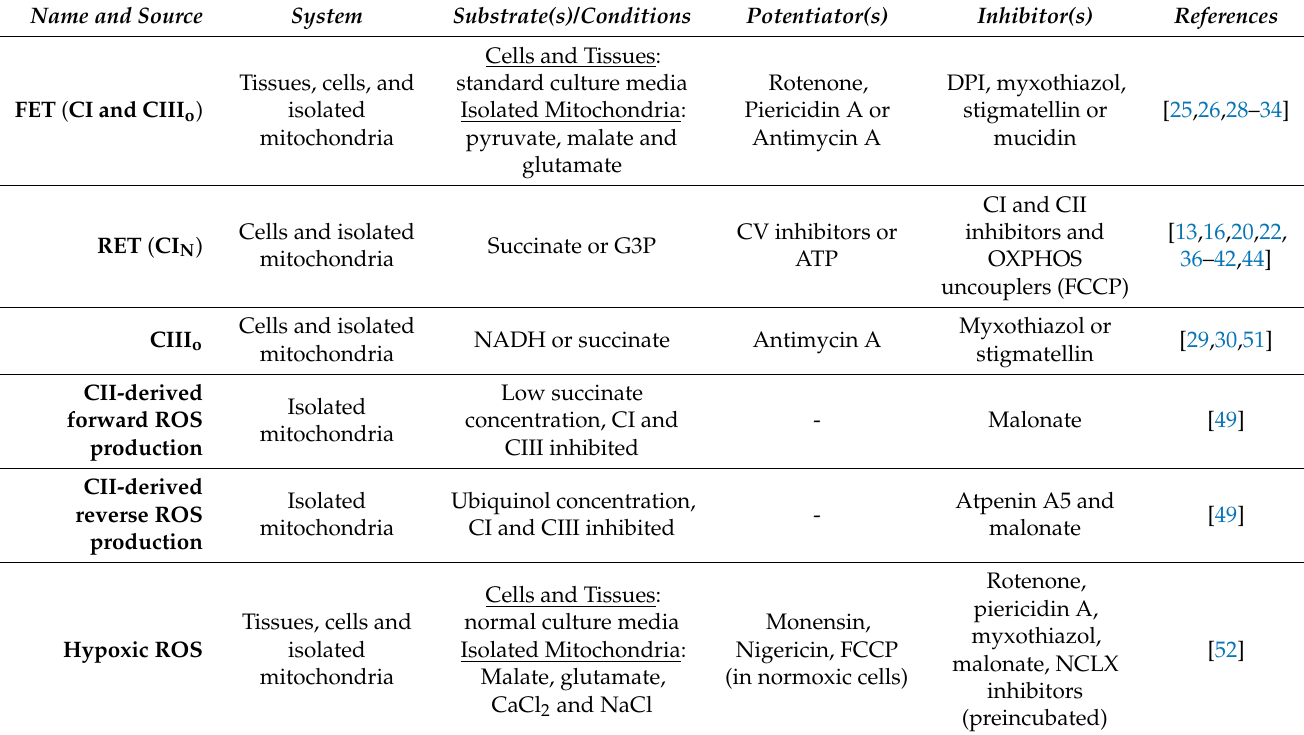
sources of ROS under precise experimental conditions (Table 1) [34]. Table 1. Summary of the main ROS sources in mitochondria. Respiratory enzymes are able to produce ROS in forward and reverse reactions, as well as under specific physiological conditions, such during acute hypoxia. Biological material is